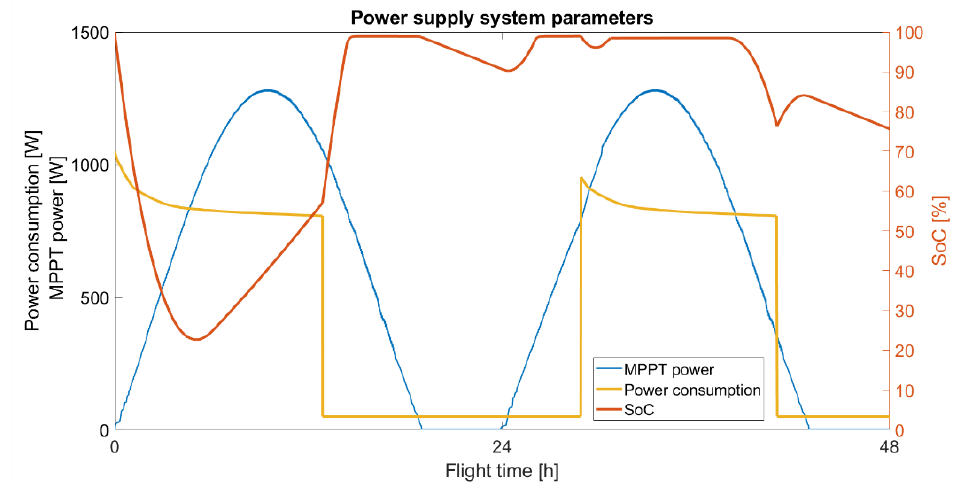
Figure 30. TwinStratos 12 20 km scenario in the summer solstice.